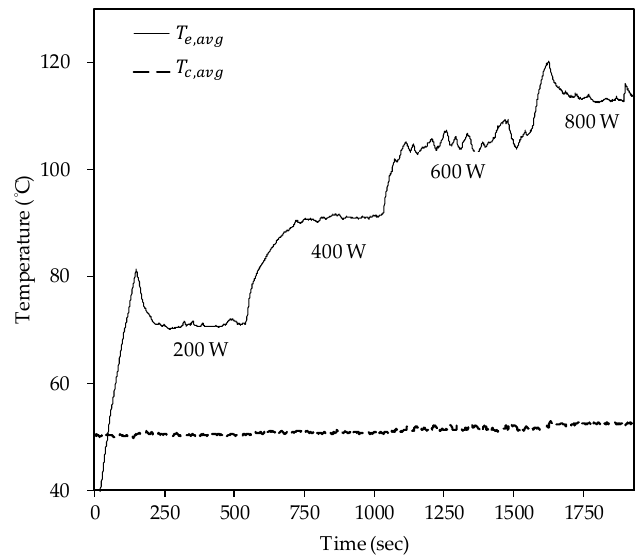
Figure 8. Average temperature variation vs. time for input power 200 W to 800 W; gravity-assisted condition (bottom heating mode).